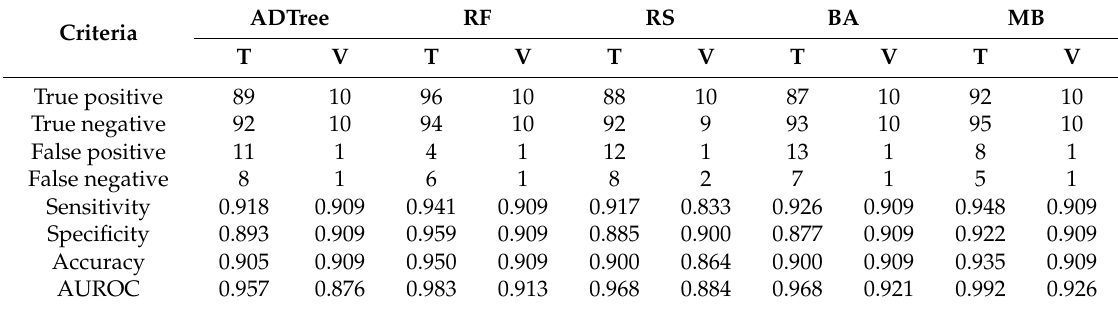
Table 9. Results of ensembles landslide modeling using combination of 90%/10% and raster resolution of 20 m.